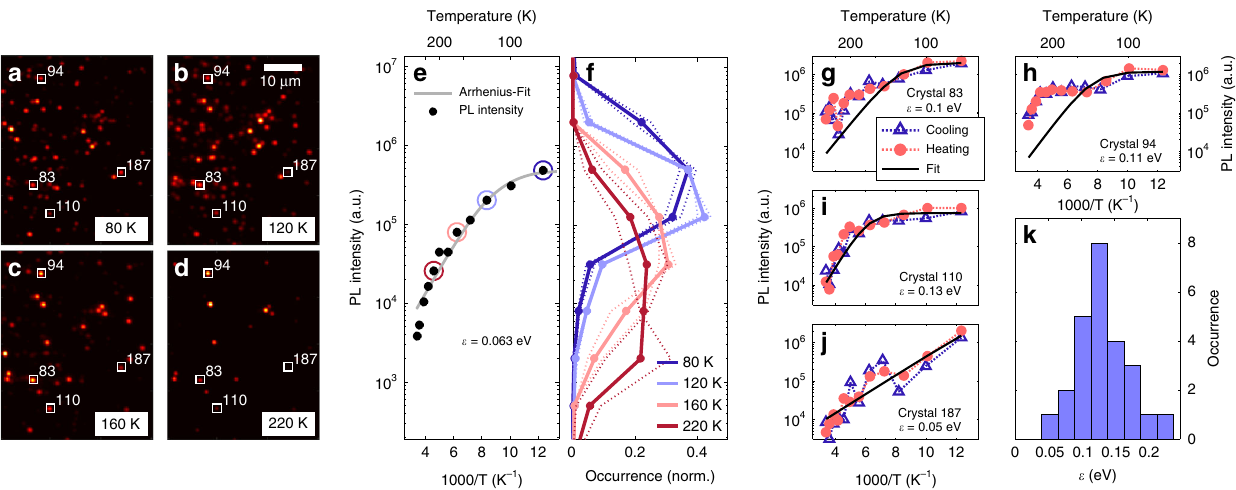
Fig. 1 Temperature dependent PL intensity. The PL images in a – d are the time-averages of the movies recorded over 100 s with 50 ms exposure time of the same sample region at temperatures of 80, 120, 160 and 220K, respectively. Several crystals in this region are marked. Panel e shows the overall PL intensity of this region, for which the signal was integrated over all pixels of the image and averaged over 100 s of the movie recording time. The gray line represents an Arrhenius- fi t giving an activation energy ε of 0.063 eV. The circled data points indicate some selected temperatures, for which we show the corresponding distributions of the PL intensities of individual crystals in f . Panels g – j show the temperature-dependent PL intensity of the four individual nanocrystals, which are marked in a – d . We fi t this data with Eq. (1) to demonstrate strong deviations from the Arrhenius activation law. More fi tting examples can be found in Supplementary Figure 2. Panel k shows a distribution of the apparent activation energies ε obtained by fi tting PL ( T ) of these 25 crystals. The sample was excited at 458 nm (CW) with an average excitation power density of 0.3 W cm − 2 (for calculation of the excitation power density, see Supplementary Note 2). The data presented in Figs. 2 – 4 was recorded under the same excitation conditions